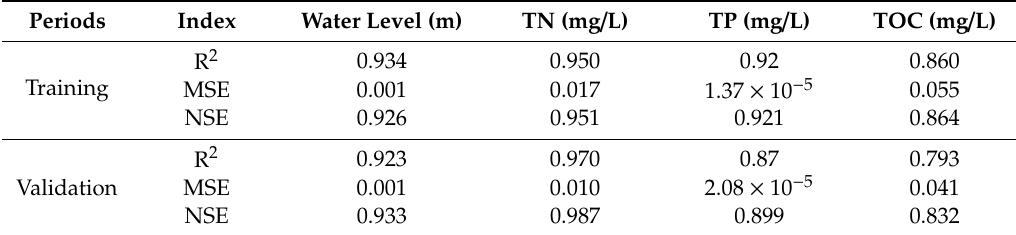
Figure 4. Comparison of the observed and simulated water level for the study period: ( a ) training and ( b ) validation periods. Table 2. Performance index of water level and water quality simulation.